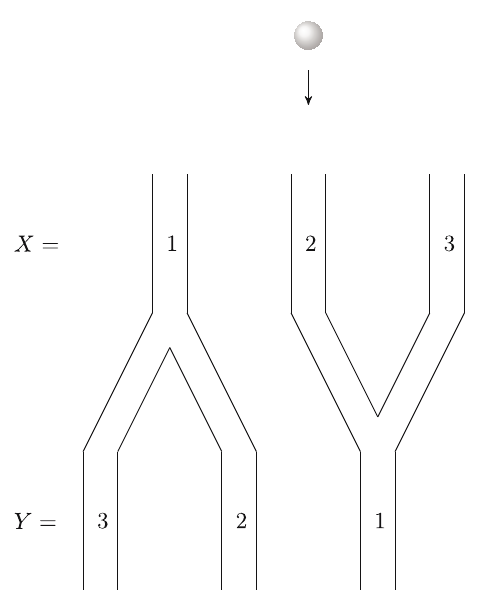
Figure 1: A ball enters our mechanical device from the top. Without additional information, we would consider all three options ( = = ) equally likely, that is, assign the probability 1/3 to them. This results in probability 2/3 for Y 1 = and probability 1/6 each for X 2 = and X 3 =